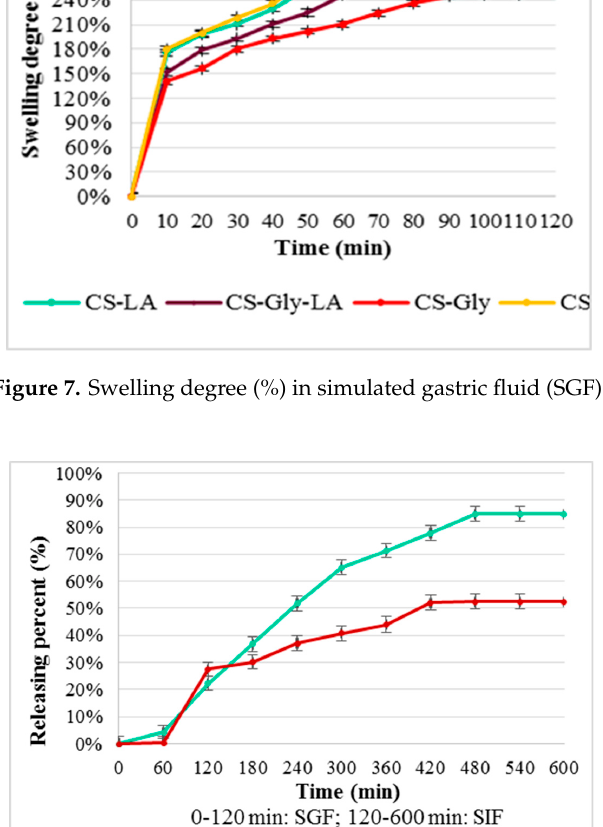
Figure 7. Swelling degree (%) in simulated gastric fluid (SGF).